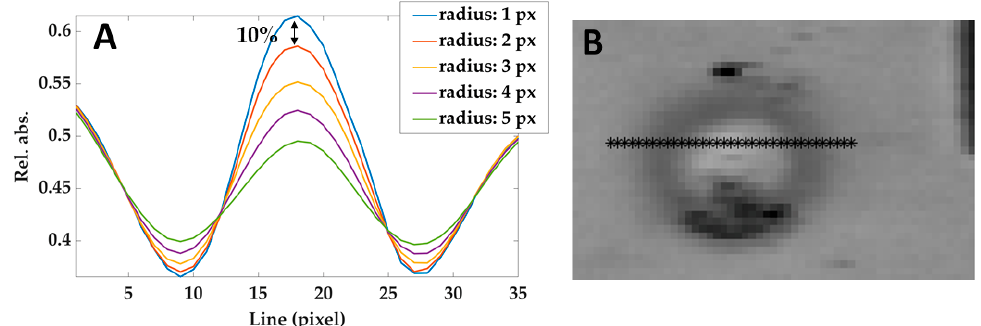
Figure 6. ( A ) Relative absorbances profiles taken from a line of pixels crossing the lesion (shown in ( B )) in the image filtered using different radius. The black arrow shows the difference between the curves obtained by using 1 pixel-filter and 2 pixels-filter and defining the maximum acceptable reduction of 10%. Similar results have been obtained at different temperatures and hypercubes.